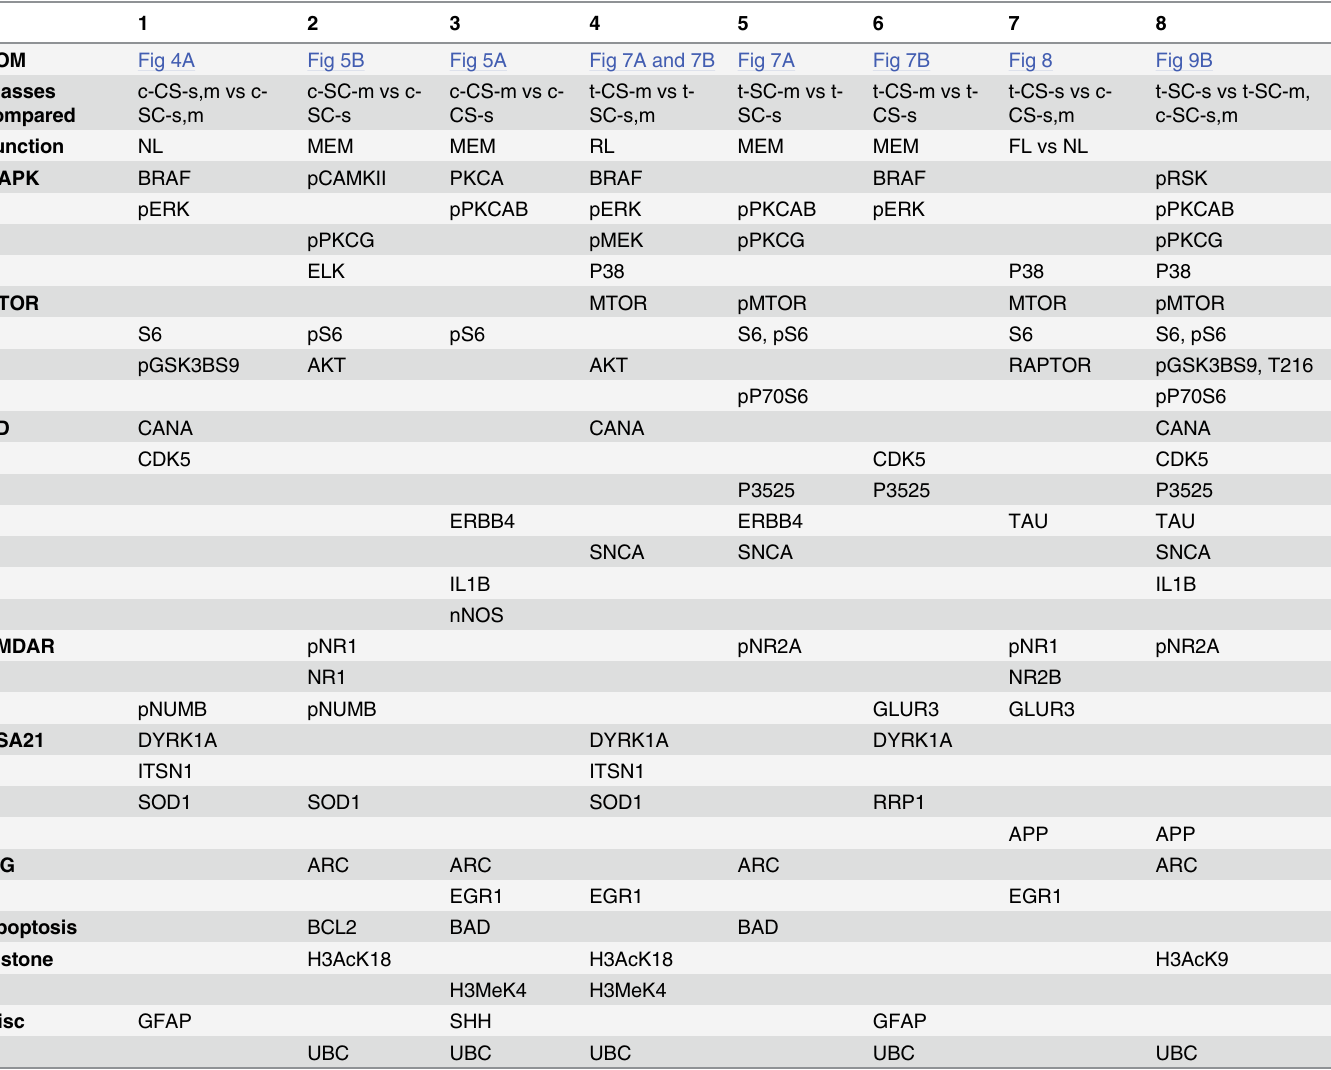
Table 3. Functional associations of discriminant proteins used to generate